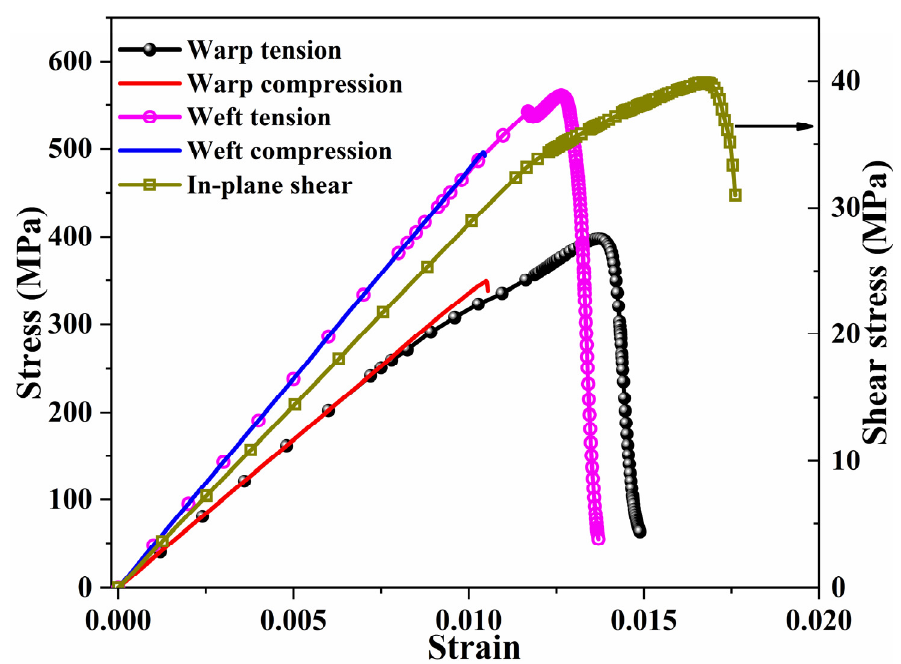
Figure 14. Typical stress–strain curves of three-dimensional orthogonal woven composite with no voids under different uniaxial loadings.